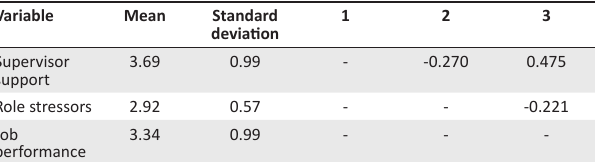
FIGURE 5: Diagram of the supervisor support mediation model with regression coefficients, indirect effects and bootstrapped confidence intervals. TABLE 8: Means, standard deviations and intercorrelations for supervisor support, role stressors and for job performance. Variable